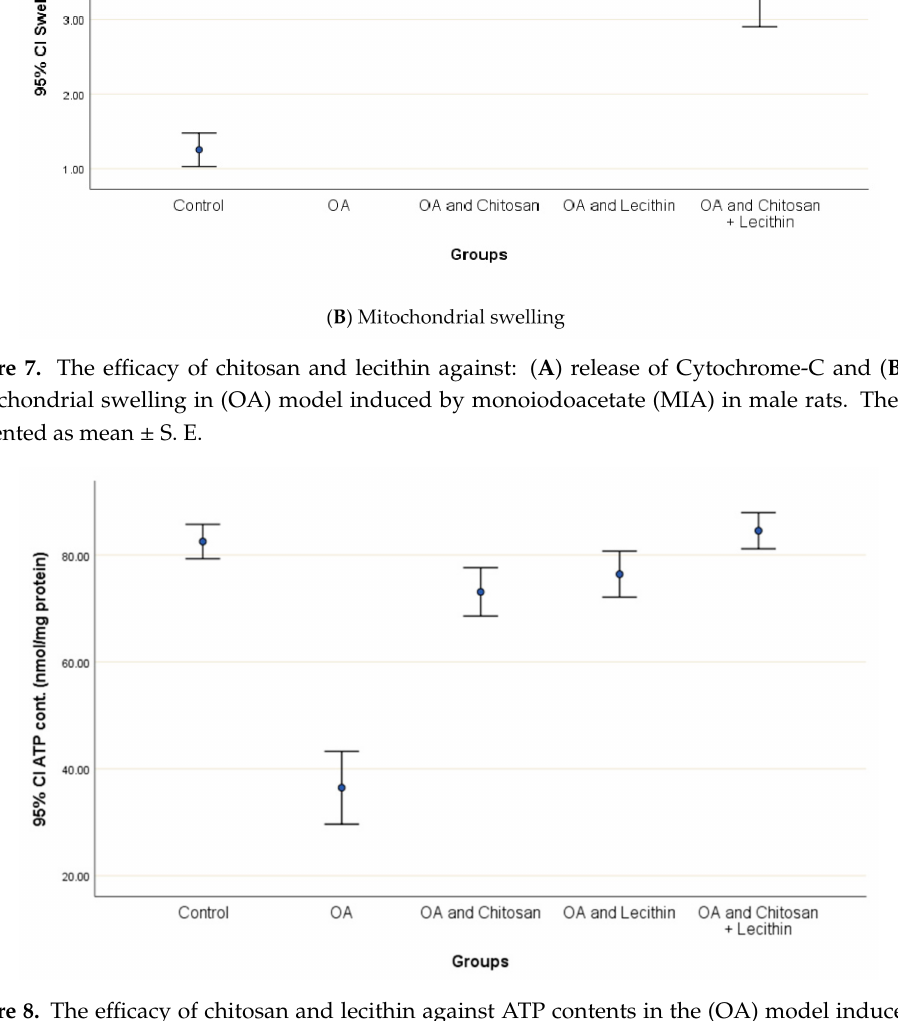
Figure 8. The e ffi cacy of chitosan and lecithin against ATP contents in the (OA) model induced by monoiodoacetate (MIA) in male rats. The data given as mean ± S.